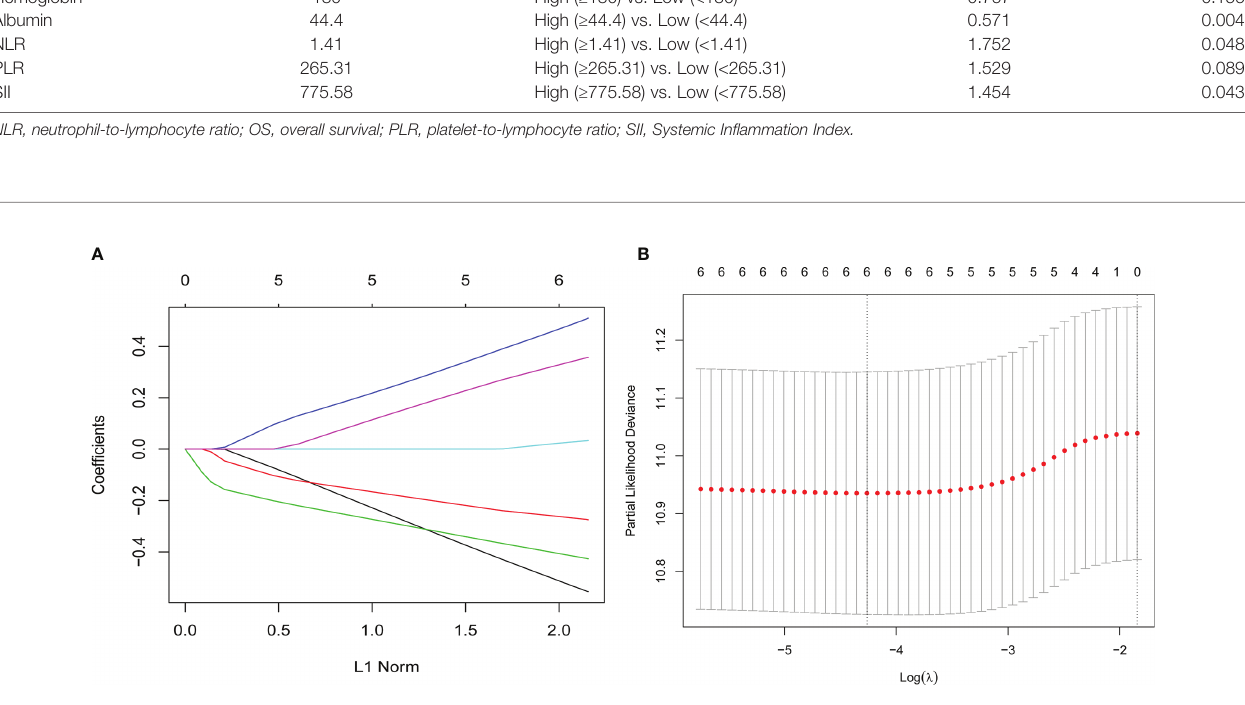
FIGURE 1 | Construction of the Risk by the least absolute shrinkage and selection operator (LASSO) model in the training cohort. (A) The LASSO-Cox regression model was used to generate the prognostic scoring system named Risk. (B) Ten-fold cross-validation for tuning parameter selection in the LASSO model via minimum criteria and 1-SE criteria. Herein, a value l = 0.014 with log ( l ) = -4.262 was selected by minimum criteria.